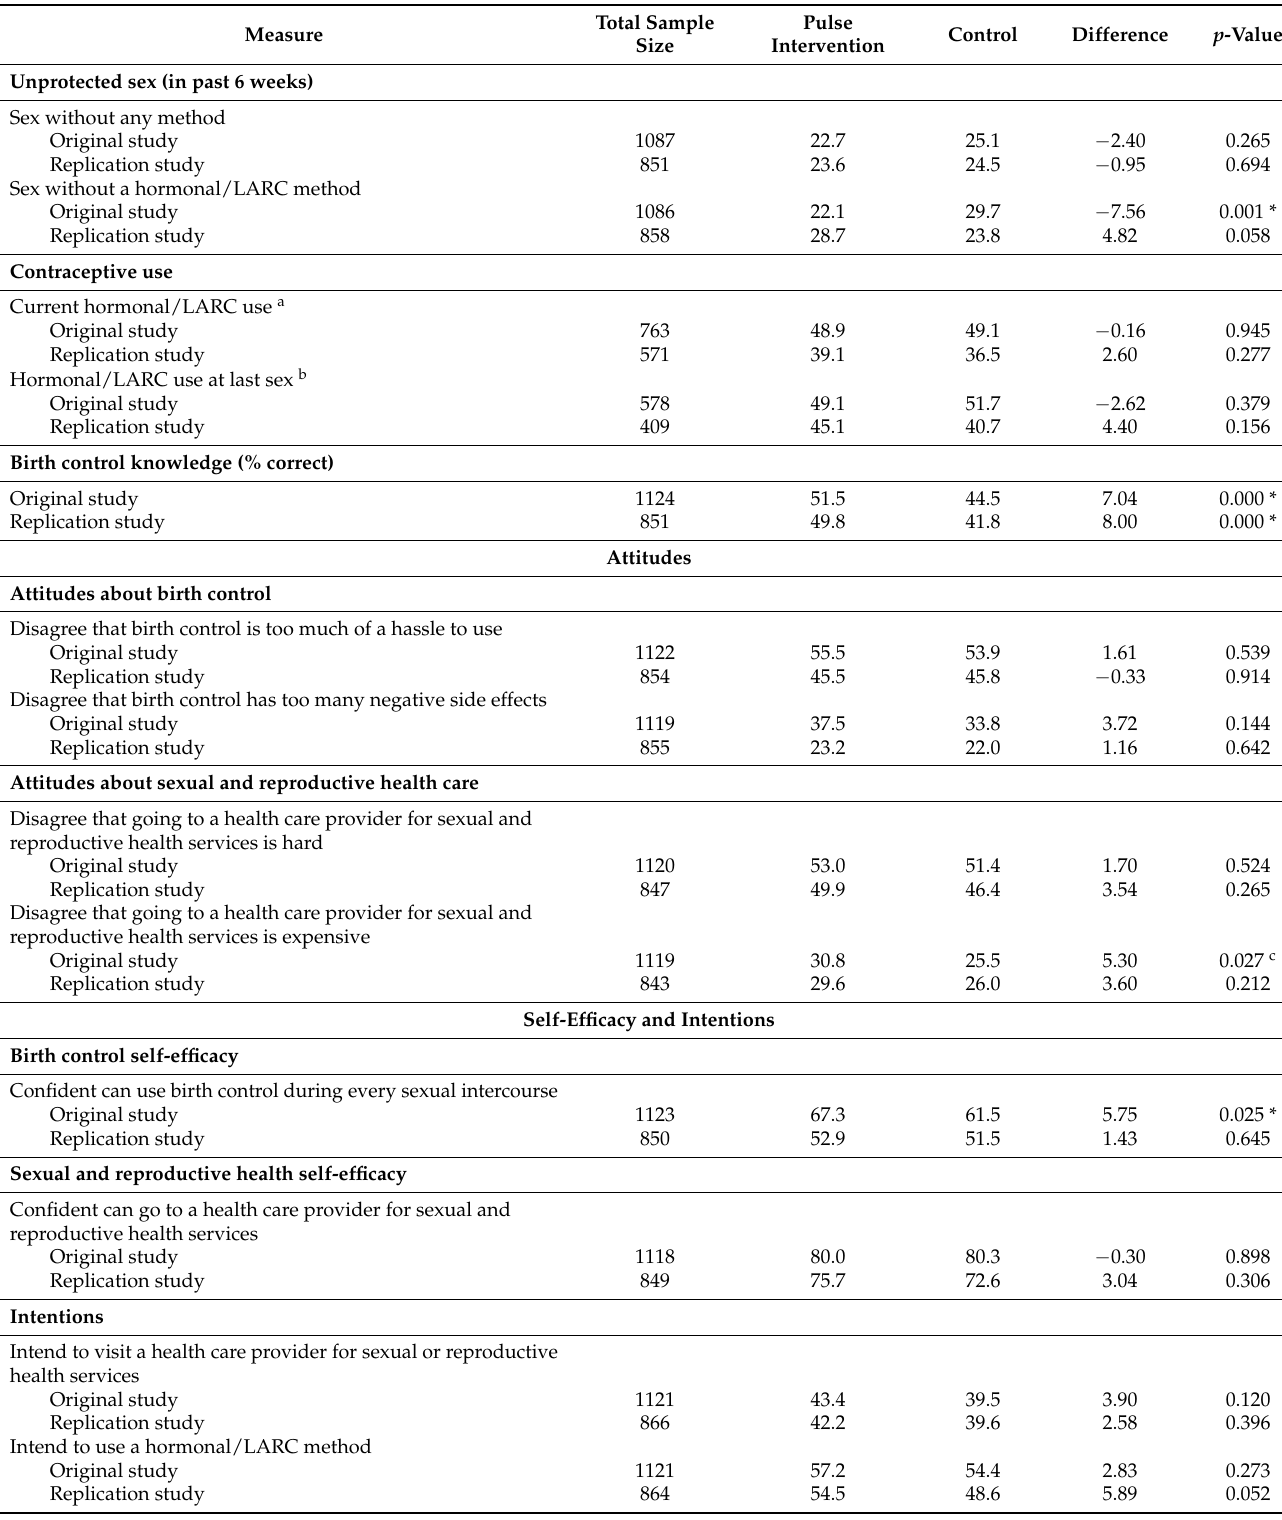
Table 3. Impacts on primary and secondary outcomes at six-week follow-up, for original study [16] and current replication